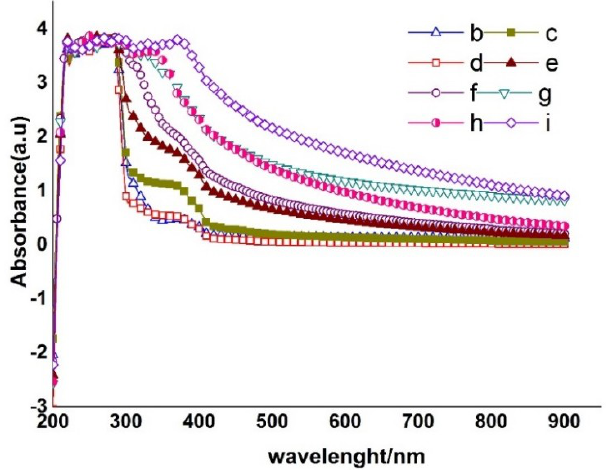
Figure 8. UV–vis absorption spectra of RGO and HGO ( b : ORGO at 35 °C, 0.5 h; c : ORGO at 35 °C, 5 h; d : ORGO at 50 °C, 0.5 h; e : ORGO at 50 °C, 5 h; f : ORGO at 80 °C, 0.5 h; g : ORGO at 80 °C, 5 h; h : ORGO at 120 °C, 0.5 h; i : ORGO at 120 °C, 5 h).